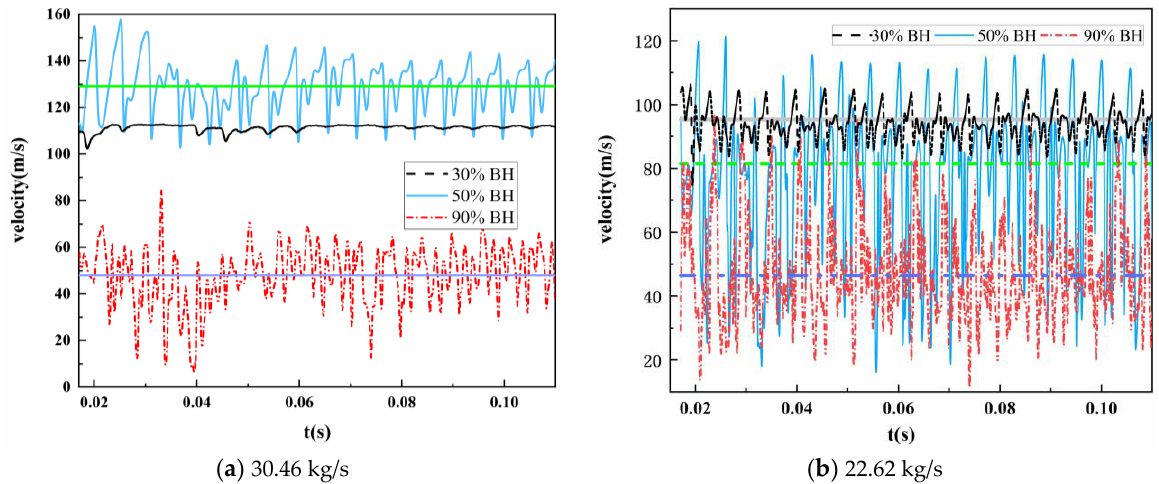
Figure 12. Velocity fluctuation analysis of monitoring points at 30%, 50%, and 90% of the blade height in a certain blade channel under non-design conditions.